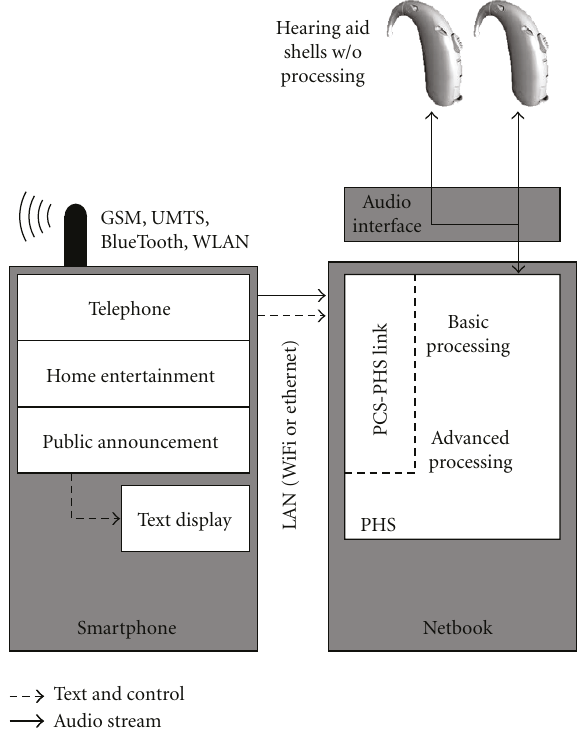
Figure 2: Prototype implementation of the PCS. The PCS services are hosted in a Smartphone, the PHS (mainly signal processing) is hosted in a portable PC. The PC connects to the hearing aid shells via a dedicated audio interface, architecture.